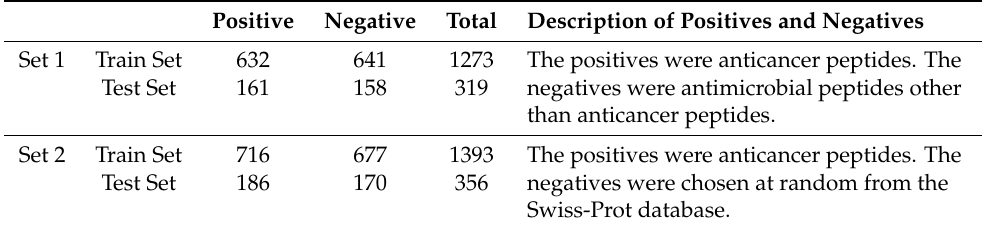
Table 3. Overview of two